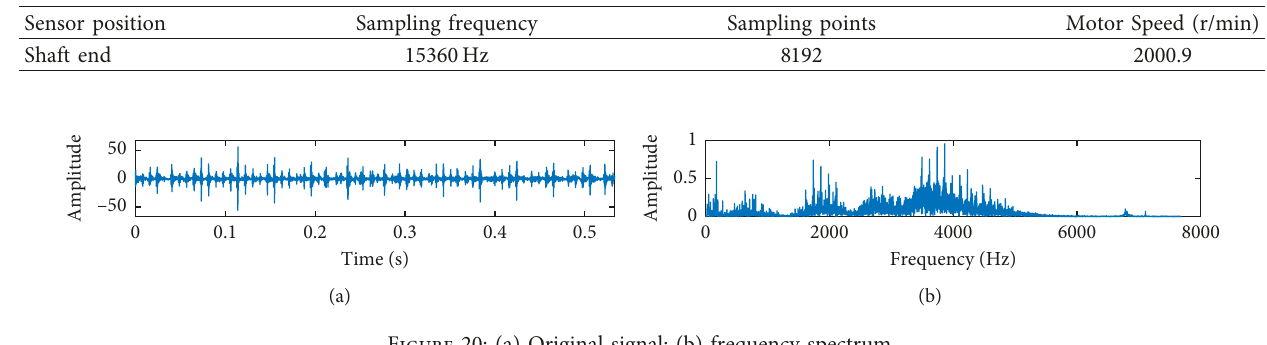
Table 7: Sampling conditions.